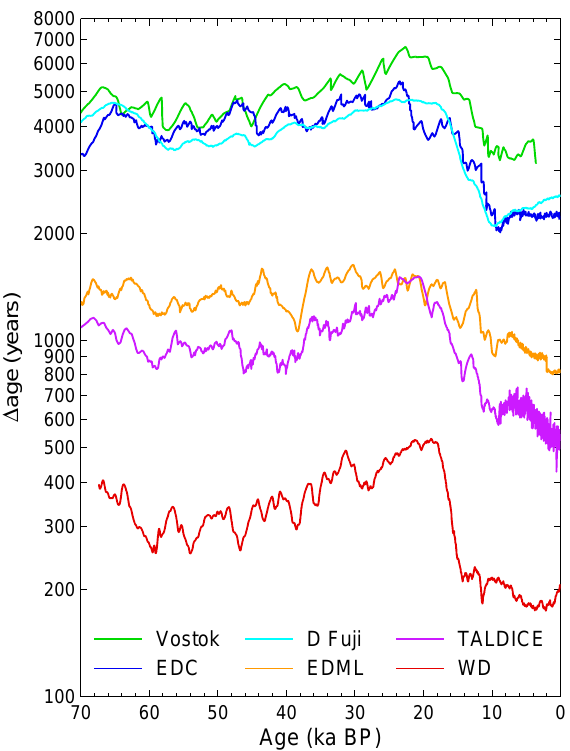
Figure 9. Comparison of (cid:49) age for different Antarctic cores, plotted on the gas age scale. Dome Fuji (cid:49) age from Kawamura et al. (2007); WD from Sect. 3; all others from Bazin et al. (2013); Veres et al.